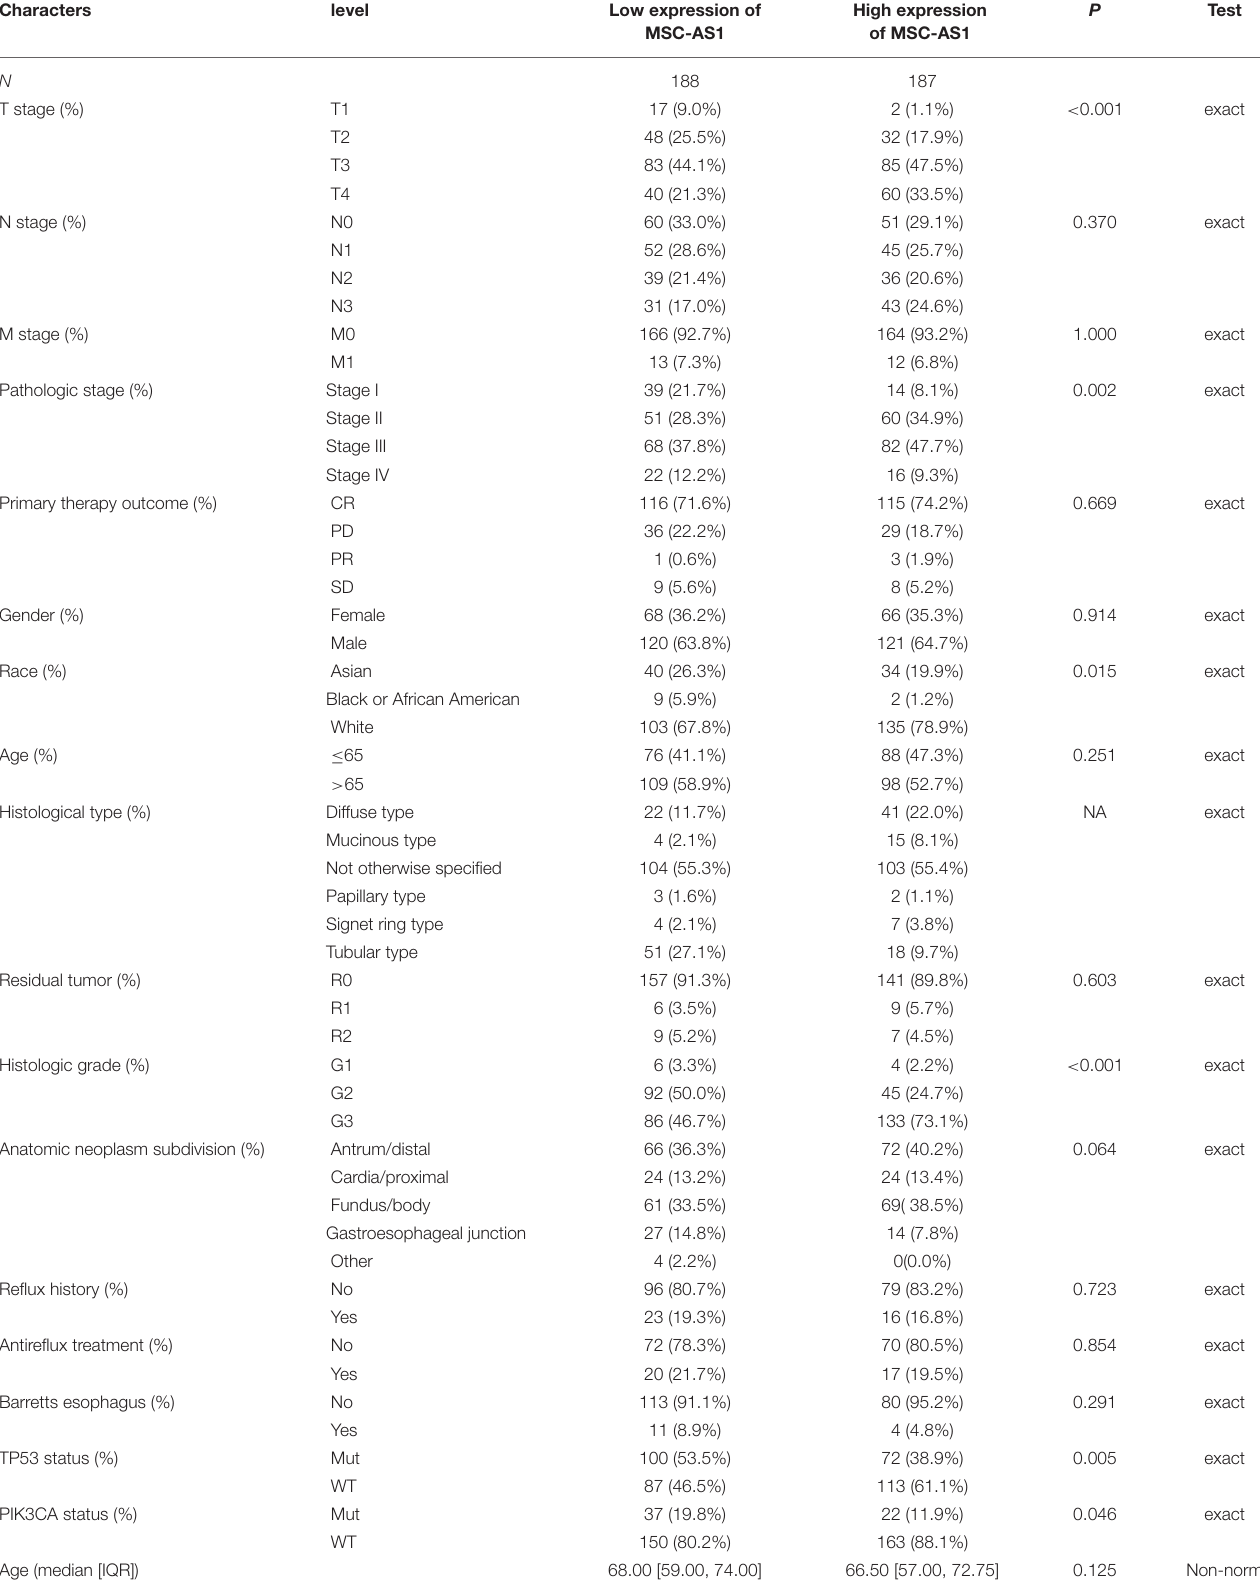
TABLE 1 | Association between long non-coding RNA (lncRNA) musculin antisense RNA1 (MSC-AS1) expression and clinicopathological features in the validation cohort.